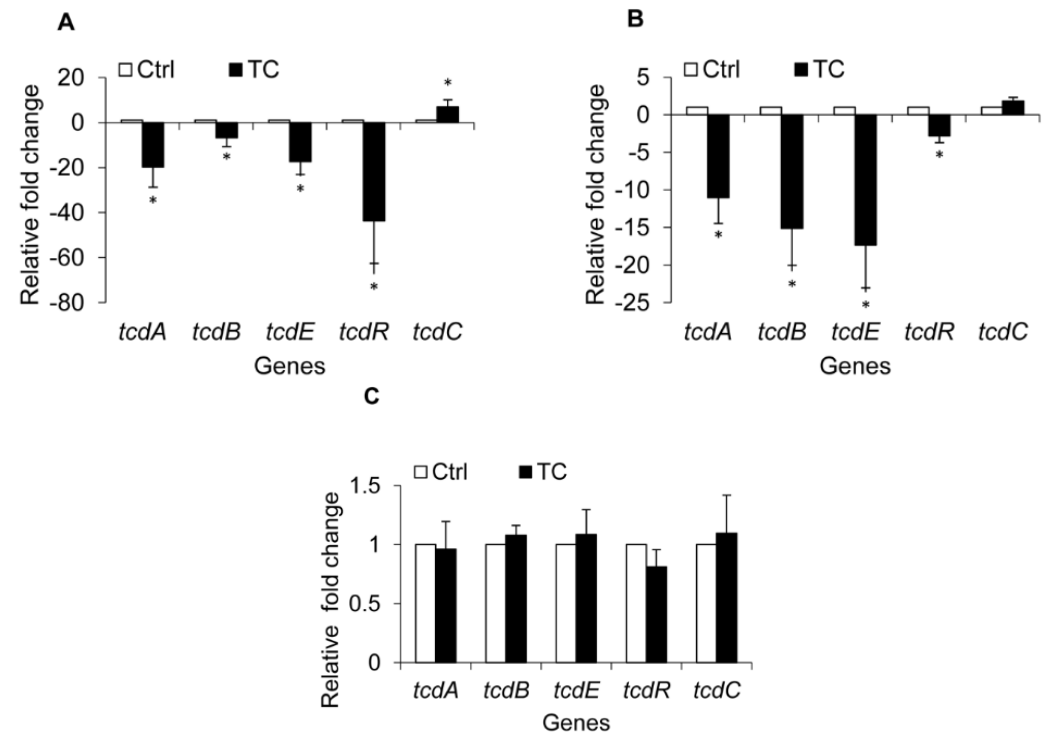
Figure 5. Effect of trans -cinnamaldehyde (TC) on C. difficile toxin regulatory genes. Brain heart infusion with or without the sub-inhibitory concentration (SIC) of TC, (0.38 mM) was inoculated (10 5 CFU/mL) separately with three hyper virulent C. difficile isolates, ATCC BAA 1870 ( A ); ATCC BAA 1053 ( B ) or ATCC BAA 1805 ( C ), and incubated anaerobically at 37 °C for 72 h. Bacterial pellets were harvested at 6 and 12 h for RNA isolation and RT-qPCR for toxin regulatory genes. * Treatments significantly differed from the controls ( p <